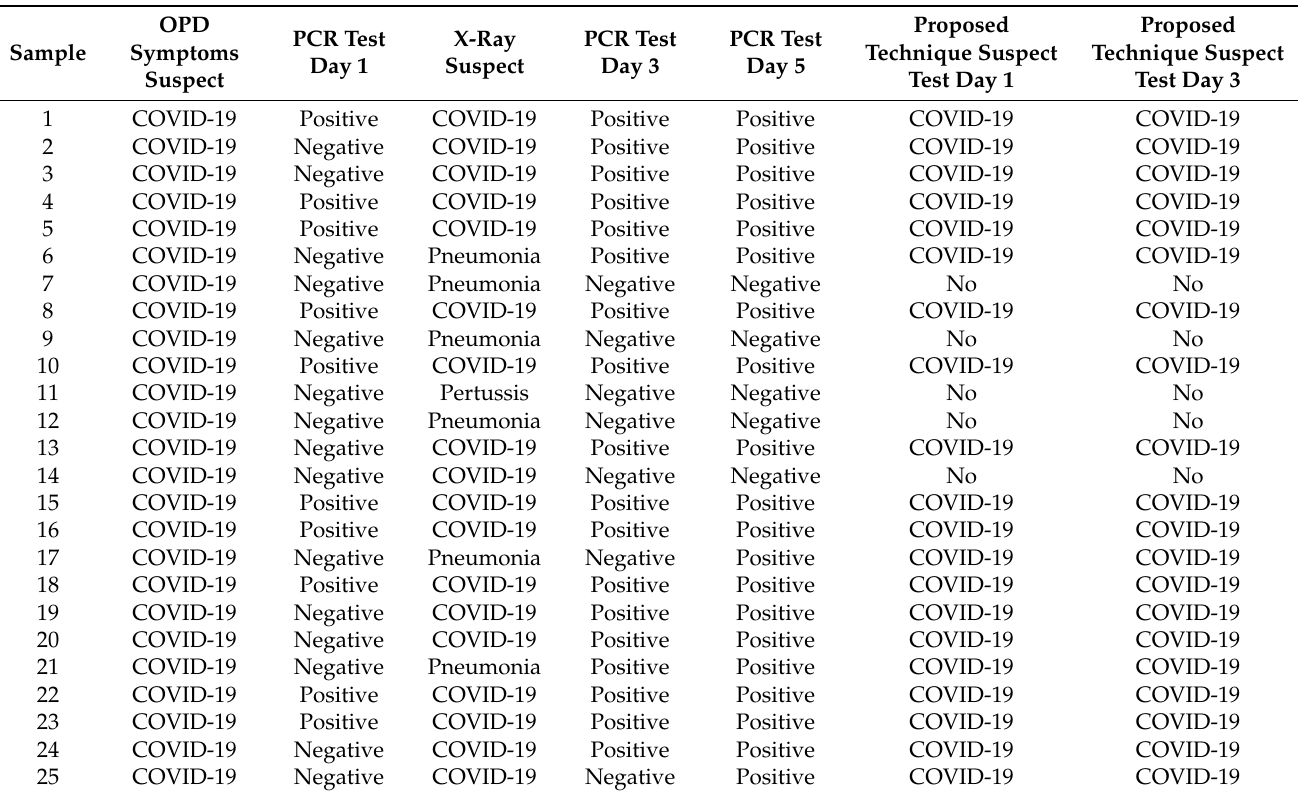
Table 3. Collected data for 25 samples with different stages OPD symptoms history, PCR results for day 1 (day of observation), 3 and 5 with our proposed technique